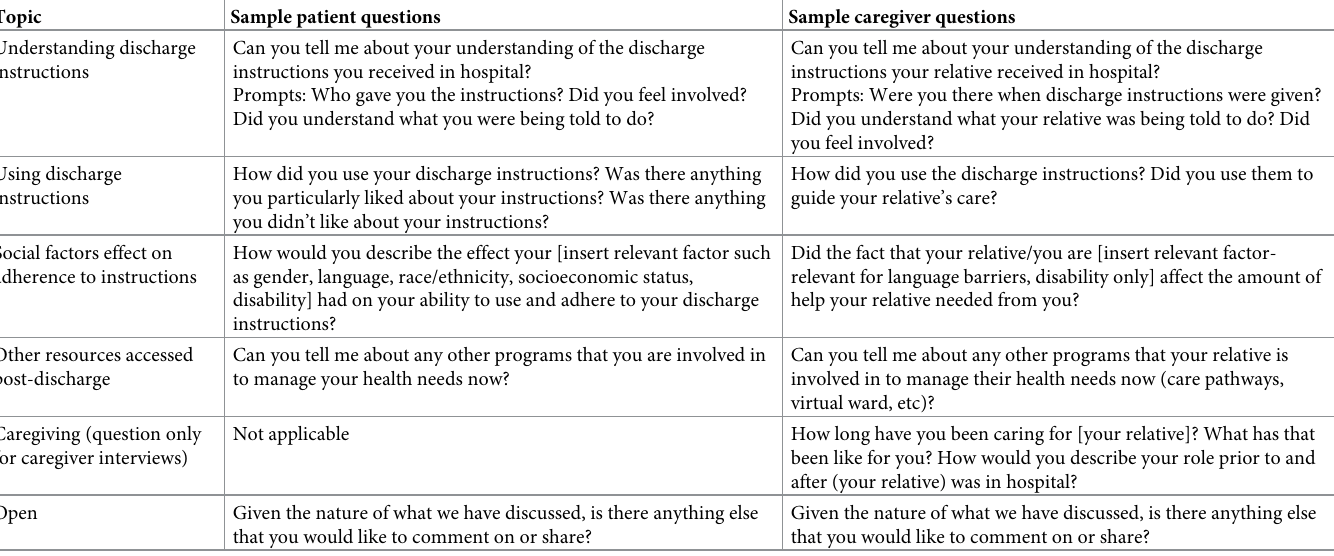
Table 1. Patient and caregiver interview topics and